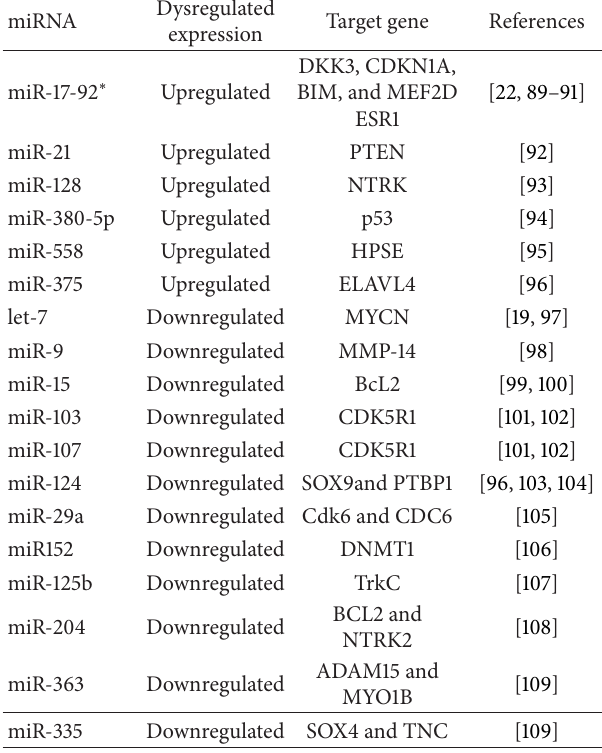
Table 2: Previous research identifying miRNAs involved in NB pathogenesis and clinical